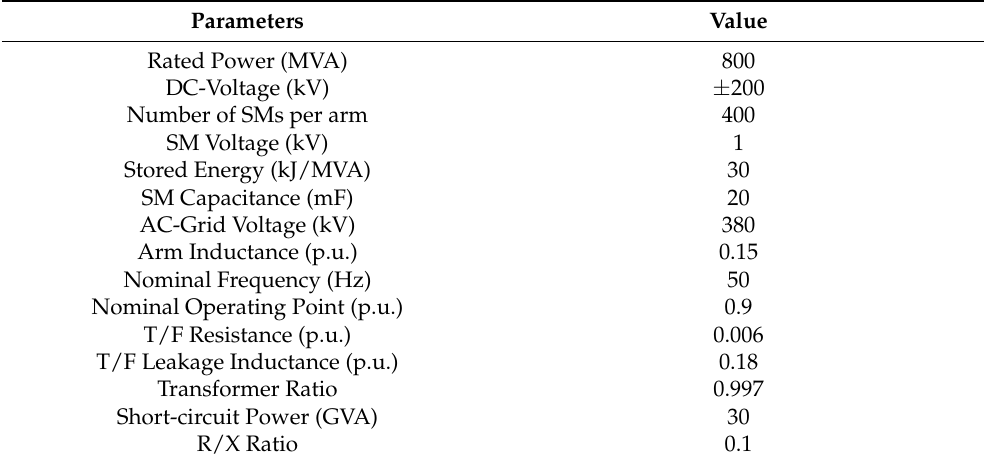
Table 9. Parameters of the MMC-HVDC model.